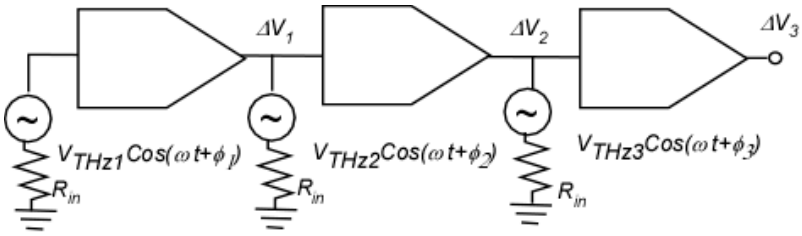
Figure 9. Schematic of the two-stage TeraFET amplifier detector with the THz signals applied to each stage with a phase shift.